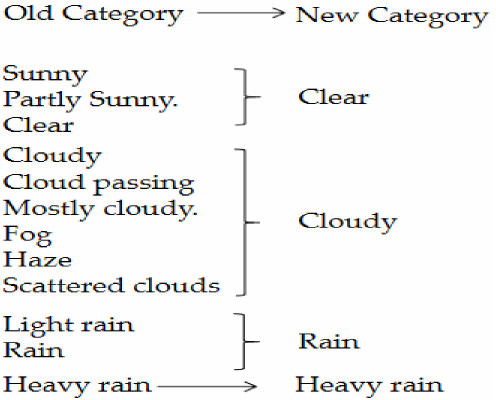
Figure 3. Weather categories from historical Weather data.